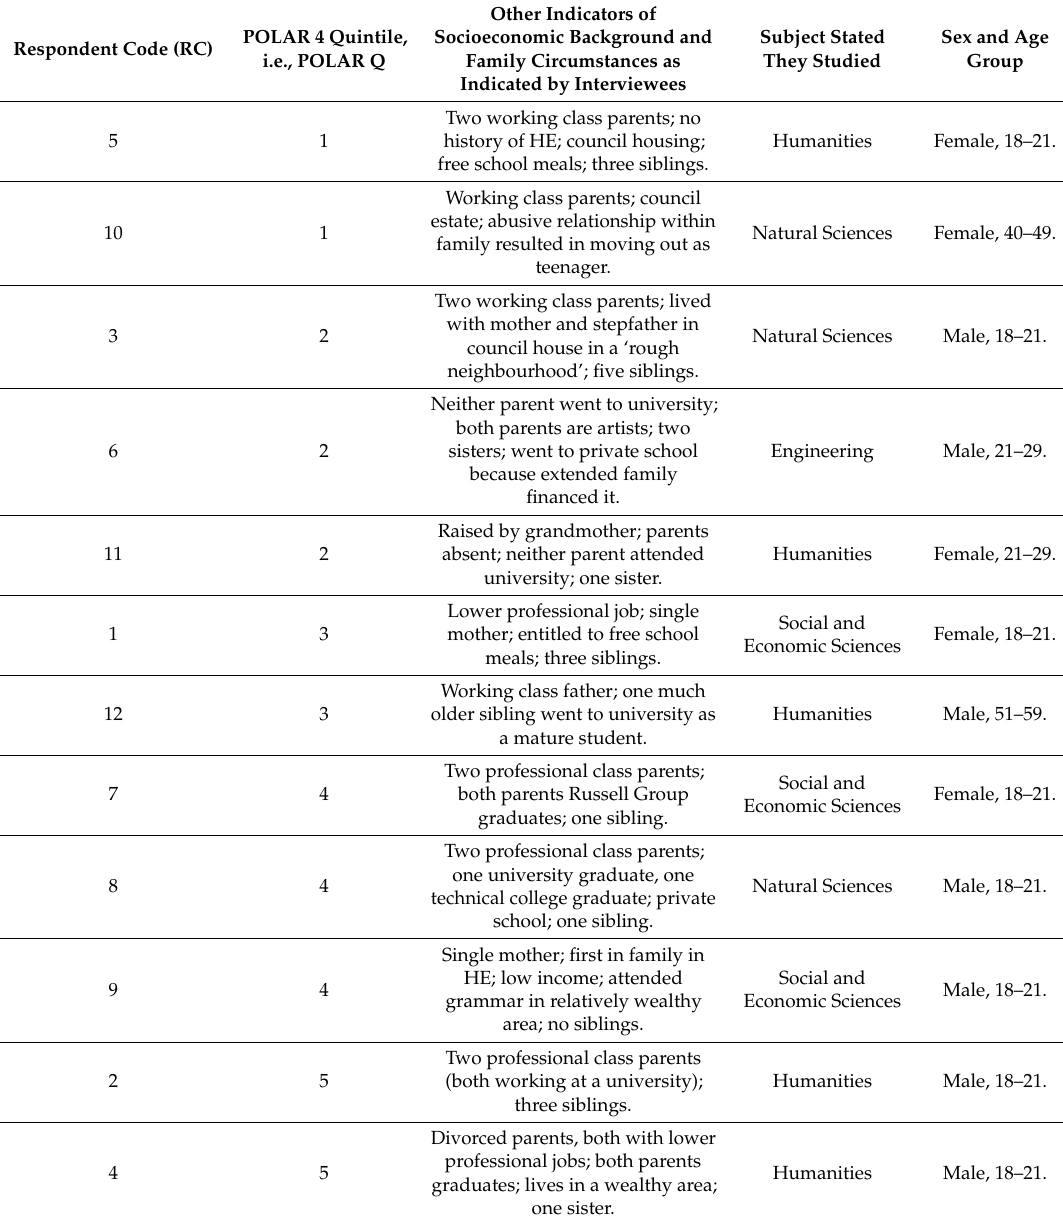
Table 1. Overview of respondents and their core characteristics (in order of POLAR 4